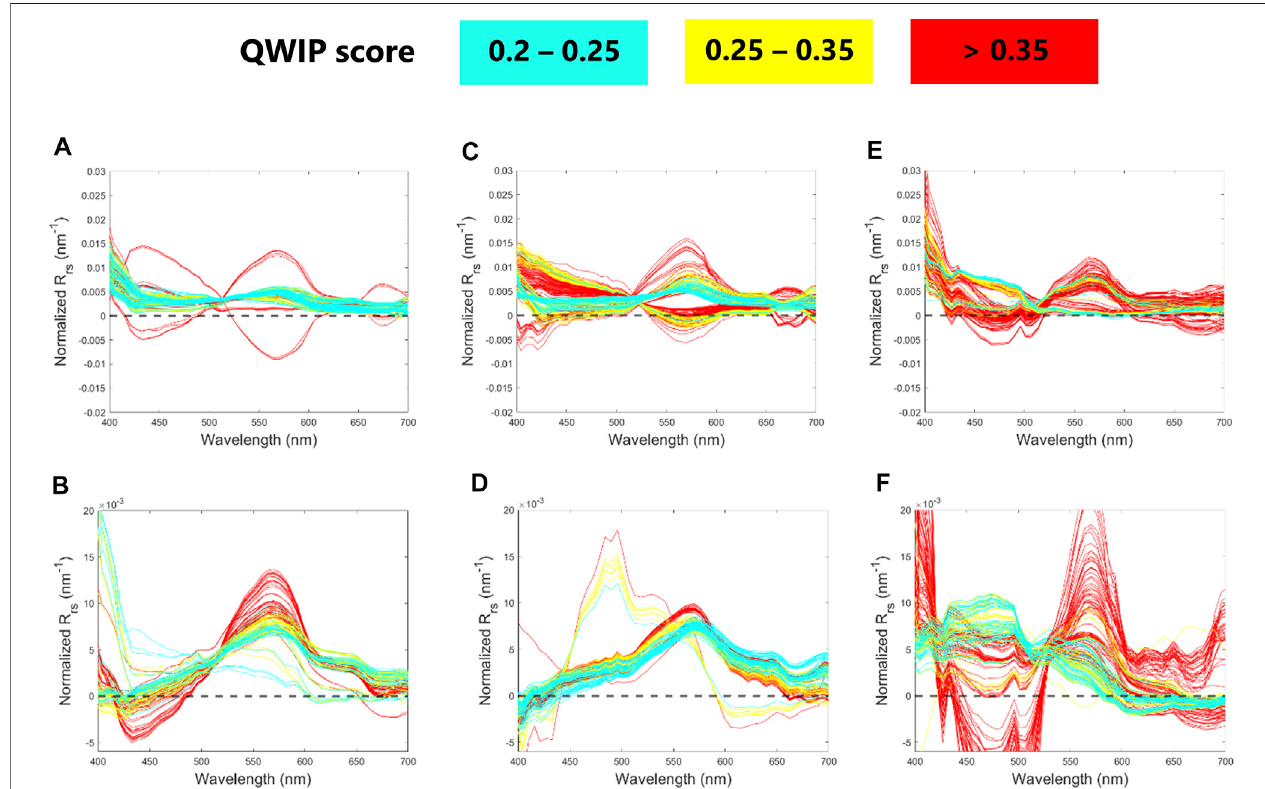
FIGURE 11 | HICO spectra that fail quality control criteria by falling above (A,C,E) or below (B,D,F) a nominal QWIP threshold (0.2), for a diverse range of images from the (A,B) Columbia River out fl ow, USA, (C,D) Danube River out fl ow, Romania, and (E,F) Queensland, Australia.